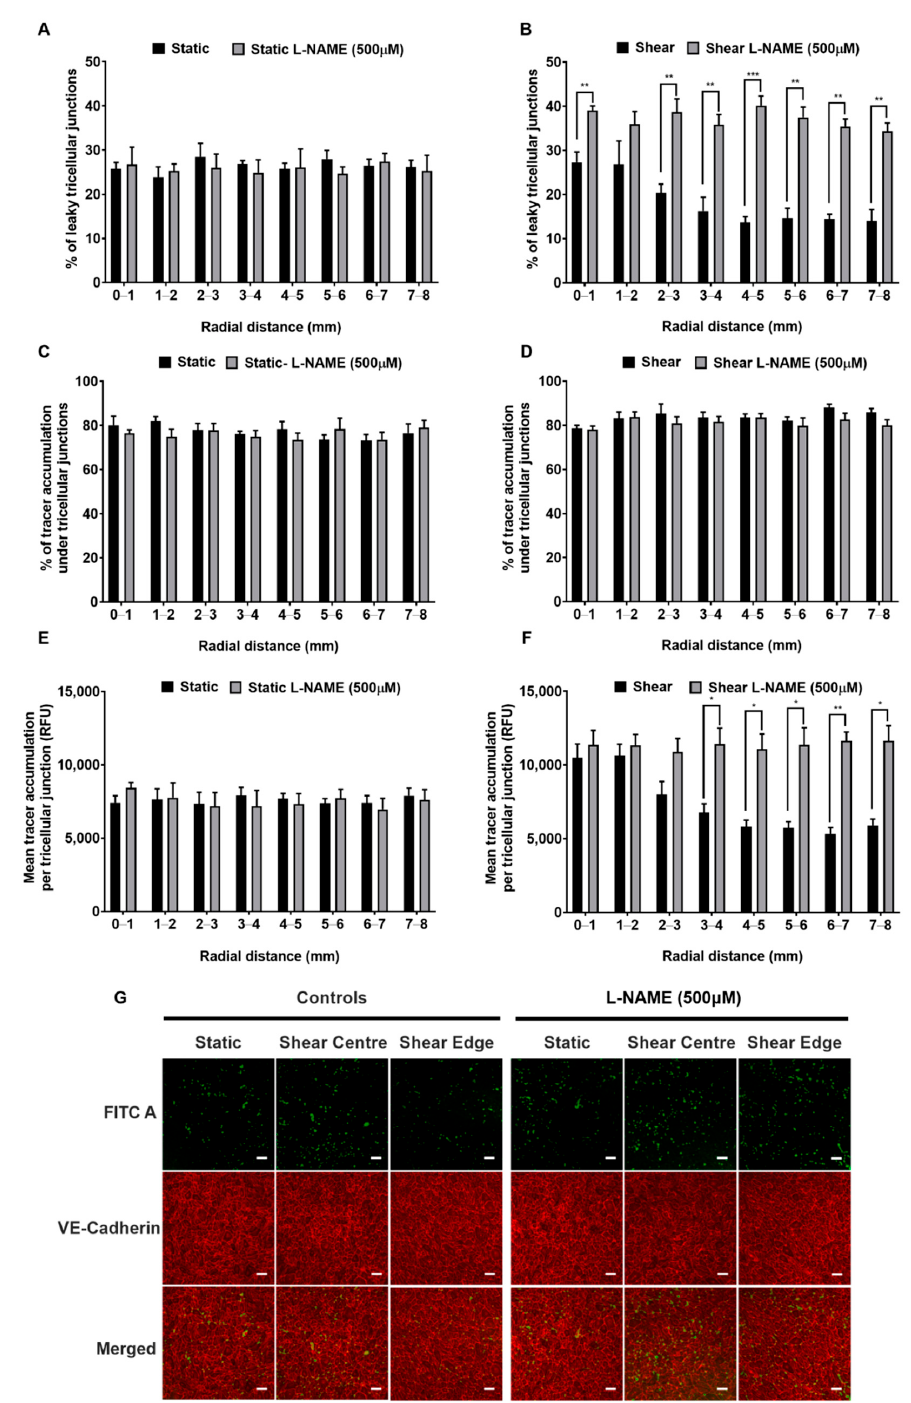
Figure 8. Percentage of permeable tricellular junctions of monolayers cultured under ( A ) static conditions and ( B ) shear. Percentage of the total accumulation due to tricellular junctions for the cells cultured under ( C ) static conditions and ( D ) shear. Mean tracer accumulation per permeable tricellular junction under ( E ) static conditions and ( F ) shear. All panels show data as a function of distance from the centre of the well, obtained with and without L-NAME treatment. ( G ) Confocal images of tracer accumulation (green spots) under PAEC monolayers cultured under static and sheared conditions, with and without L-NAME treatment. Red lines of anti-VE-cadherin immunostaining show cell boundaries. Bar = 100 µ m. Mean ± SEM, n = 3